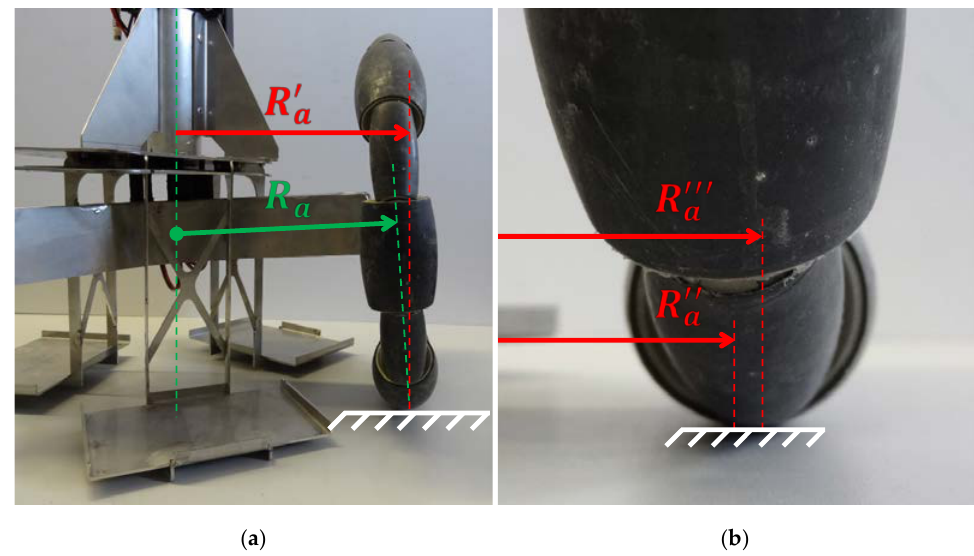
Figure 4. General view ( a ) and detail ( b ) of the point of contact with the floor and the distance from the wheel to the center of the mobile robot: R a depicts the nominal or design value (green font and lines) and R (cid:48) a the real or effective value (representing R (cid:48) a as the average value of R (cid:48)(cid:48) a and R (cid:48)(cid:48)(cid:48) a , red font and lines).